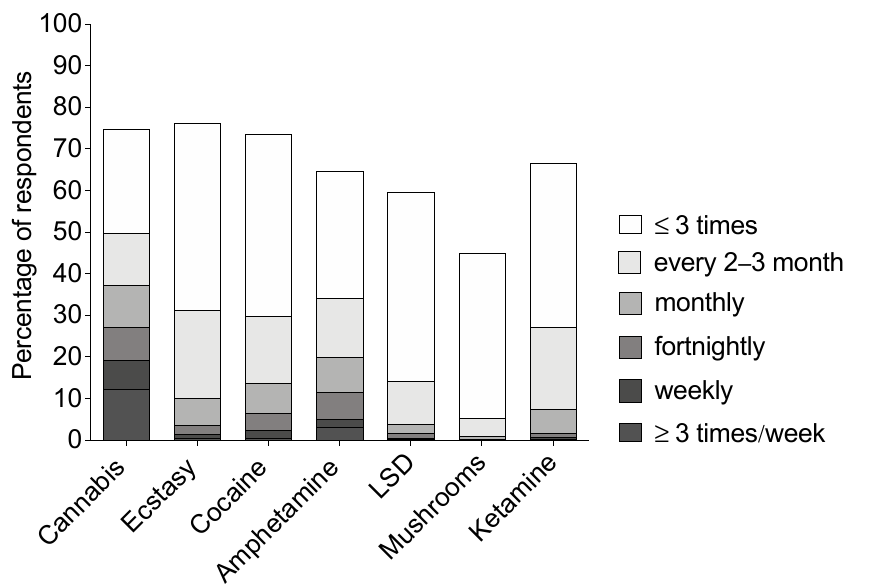
Figure 2. Drug use frequency of drug users. Frequency of drug use during the past 12 months is presented as percentage of ever users for each drug. Data are stacked as to show ‘at least’ drug use frequency. For example, whereas almost 20% (of people who had ever used cannabis) reported using cannabis at least weekly, around 50% reported using cannabis at least every 2–3 months. LSD, lysergic acid